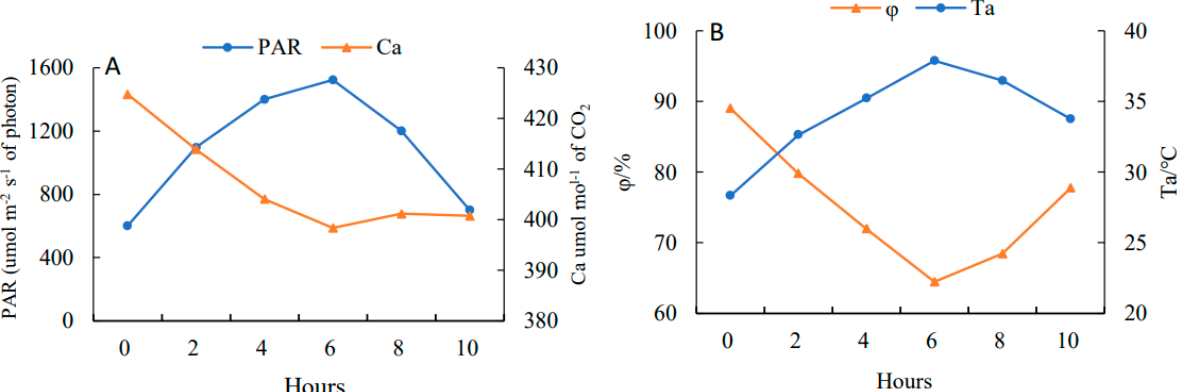
Figure 3. Diurnal variations of photosynthetically active radiation (PAR) (A), atmospheric CO 2 concentration (Ca) ( A ), atmospheric temperature (Ta) ( B ) and atmospheric humidity ( ϕ ) ( B ) in 10 h (from 7:00 to 17:00).